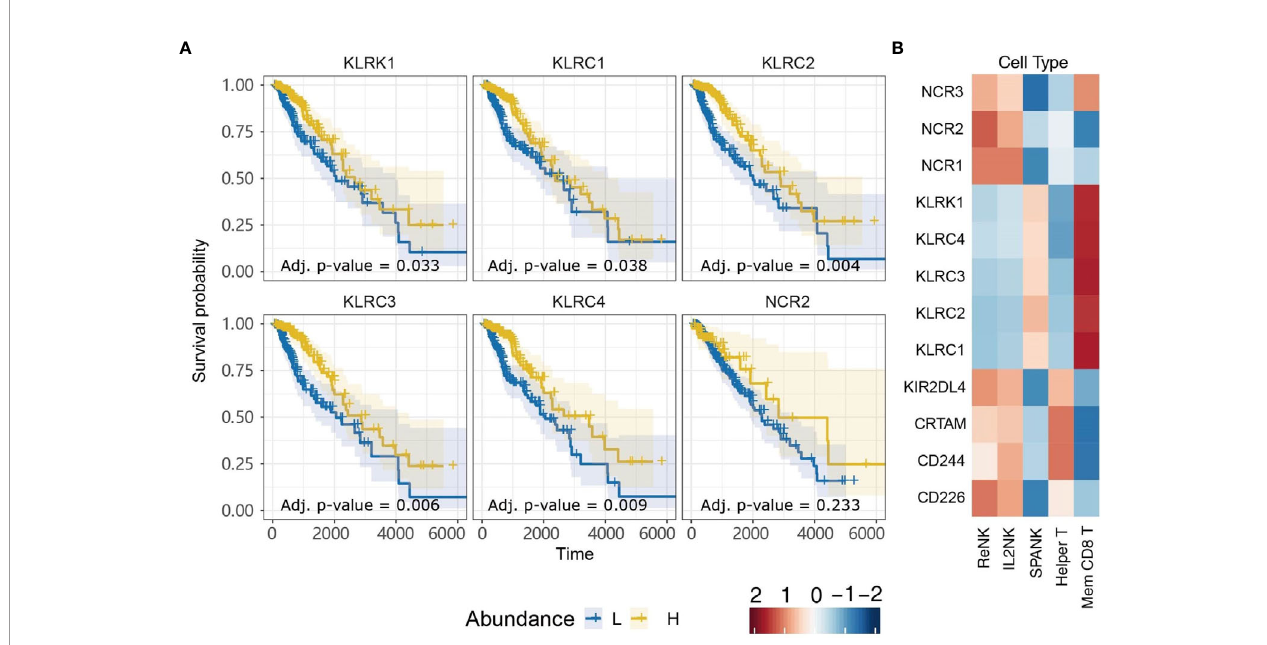
FIGURE 6 | Killer cell Lectin-like Receptor family expression is associated with more favorable TCGA LGG prognosis. (A) KM plots displaying progression-free survival of LGG patients split by median fraction into low (L) and high (H) tumor expression for the NK cell receptor genes: KLRK1, KLRC1, KLRC2, KLRC3, KLRC4 , or NCR2. (B) Heatmap displaying correlations between expression of each NK cell receptor transcript (y-axis) and each NK cell and T cell phenotype (x-axis),